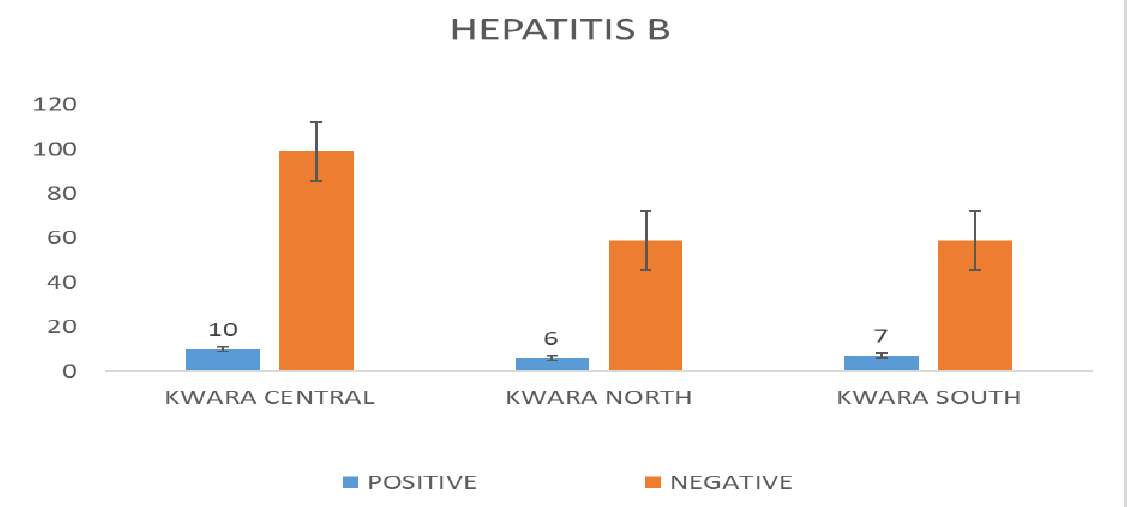
Figure 2. Hepatitis B incidences among scavenger across the three senatorial districts.